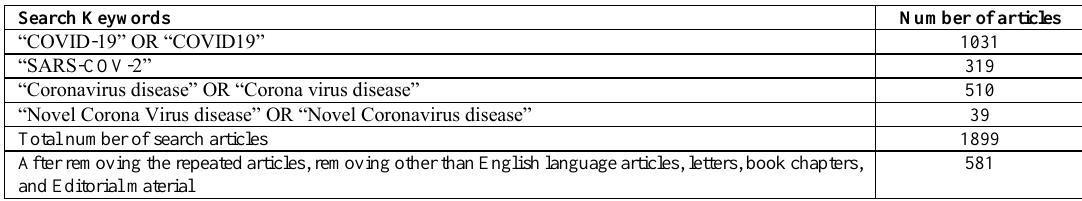
Table 1. Search keywords performed on the Scopus ®